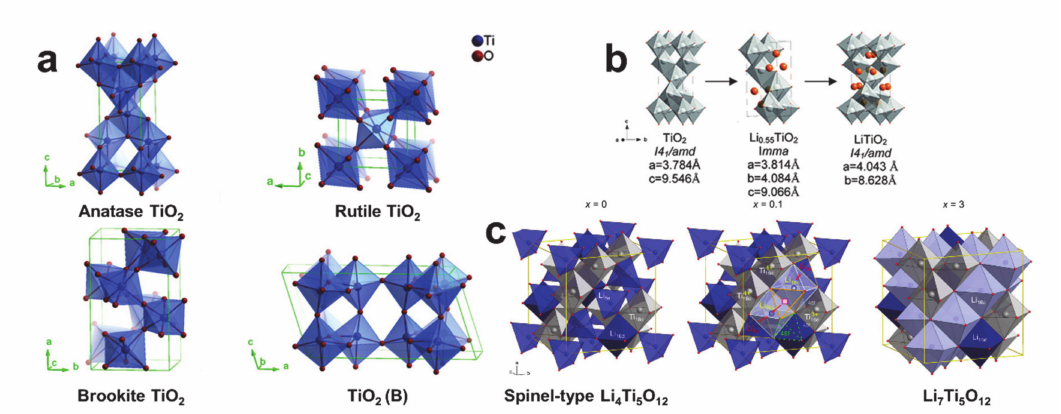
Figure 6. Crystalline structures and phase transition by lithiation of TiO 2 and Li 4 Ti 5 O 12 . ( a ) Crystalline structures and TiO 2 in di ff erent phases: anatase, rutile, brookite, and TiO 2 (B) (reprinted with permission from [77]; copyright 2014 American Chemical Society), ( b ) phase transition upon lithium insertion in anatase TiO 2 (reprinted with permission from [78]; copyright 2010 American Chemical Society), and ( c ) crystalline structural changes of spinel-type Li 4 Ti 5 O 12 as lithium occupation increases (reprinted with permission from [79]; copyright 2015 American Chemical